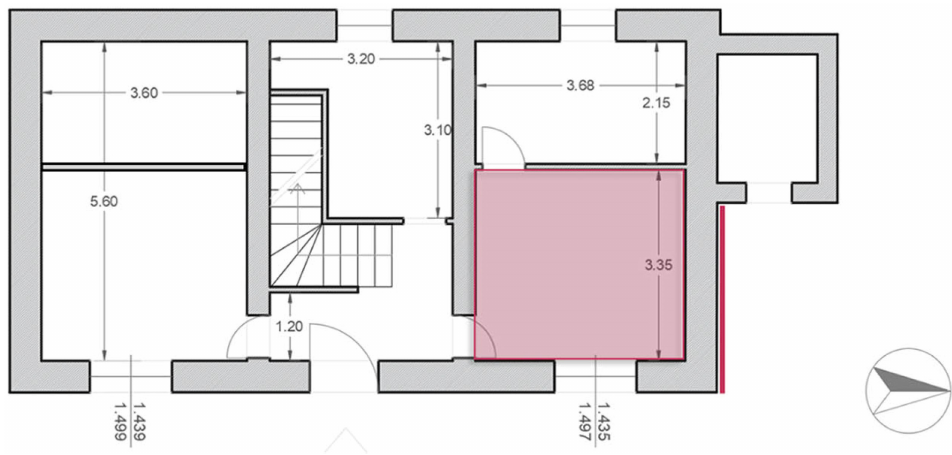
Figure 10. Test area in the living room. Vertical closure: perimeter